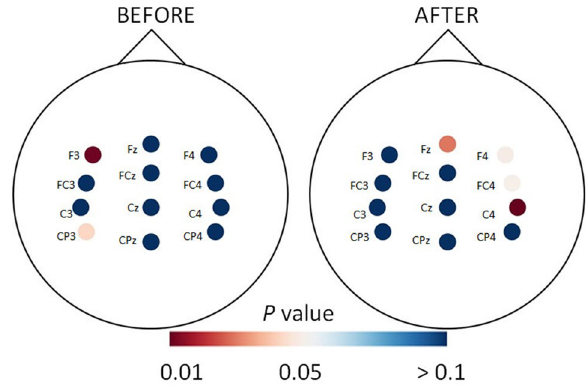
Figure 5. Heatmap depicting the P values of pairwise comparison for ERP amplitude between motor imagery of reaching (MIR) and motor imagery of grasping (MIG) before and after four weeks of motor imagery